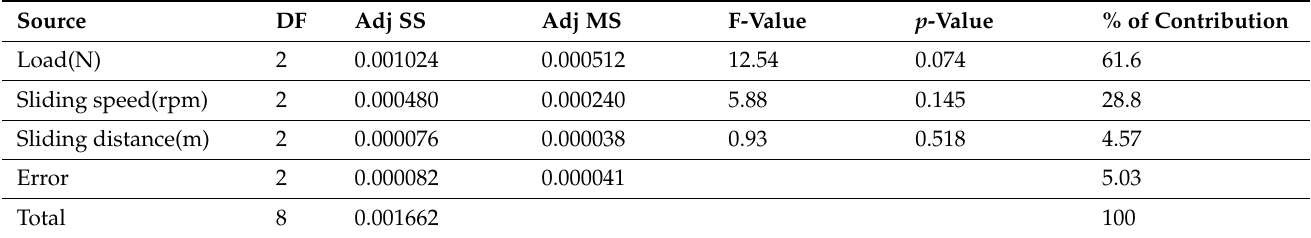
Table 12. Analysis of